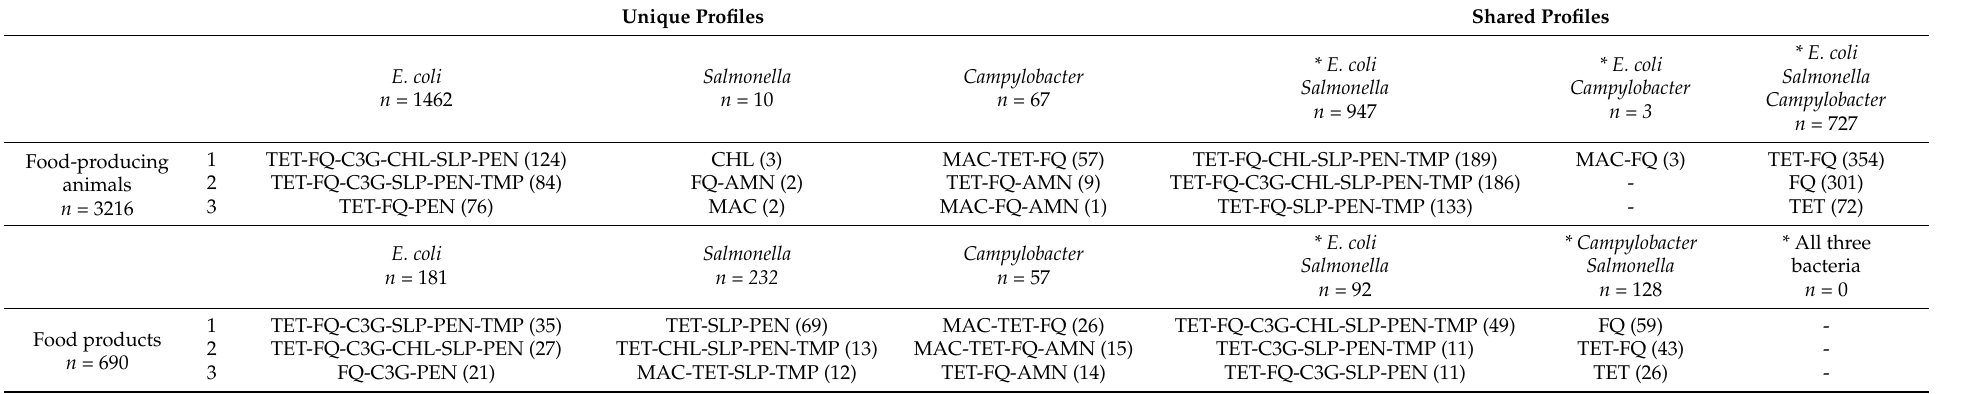
Table 1. Unique and shared profiles between bacteria in food-producing animals and derived food products,